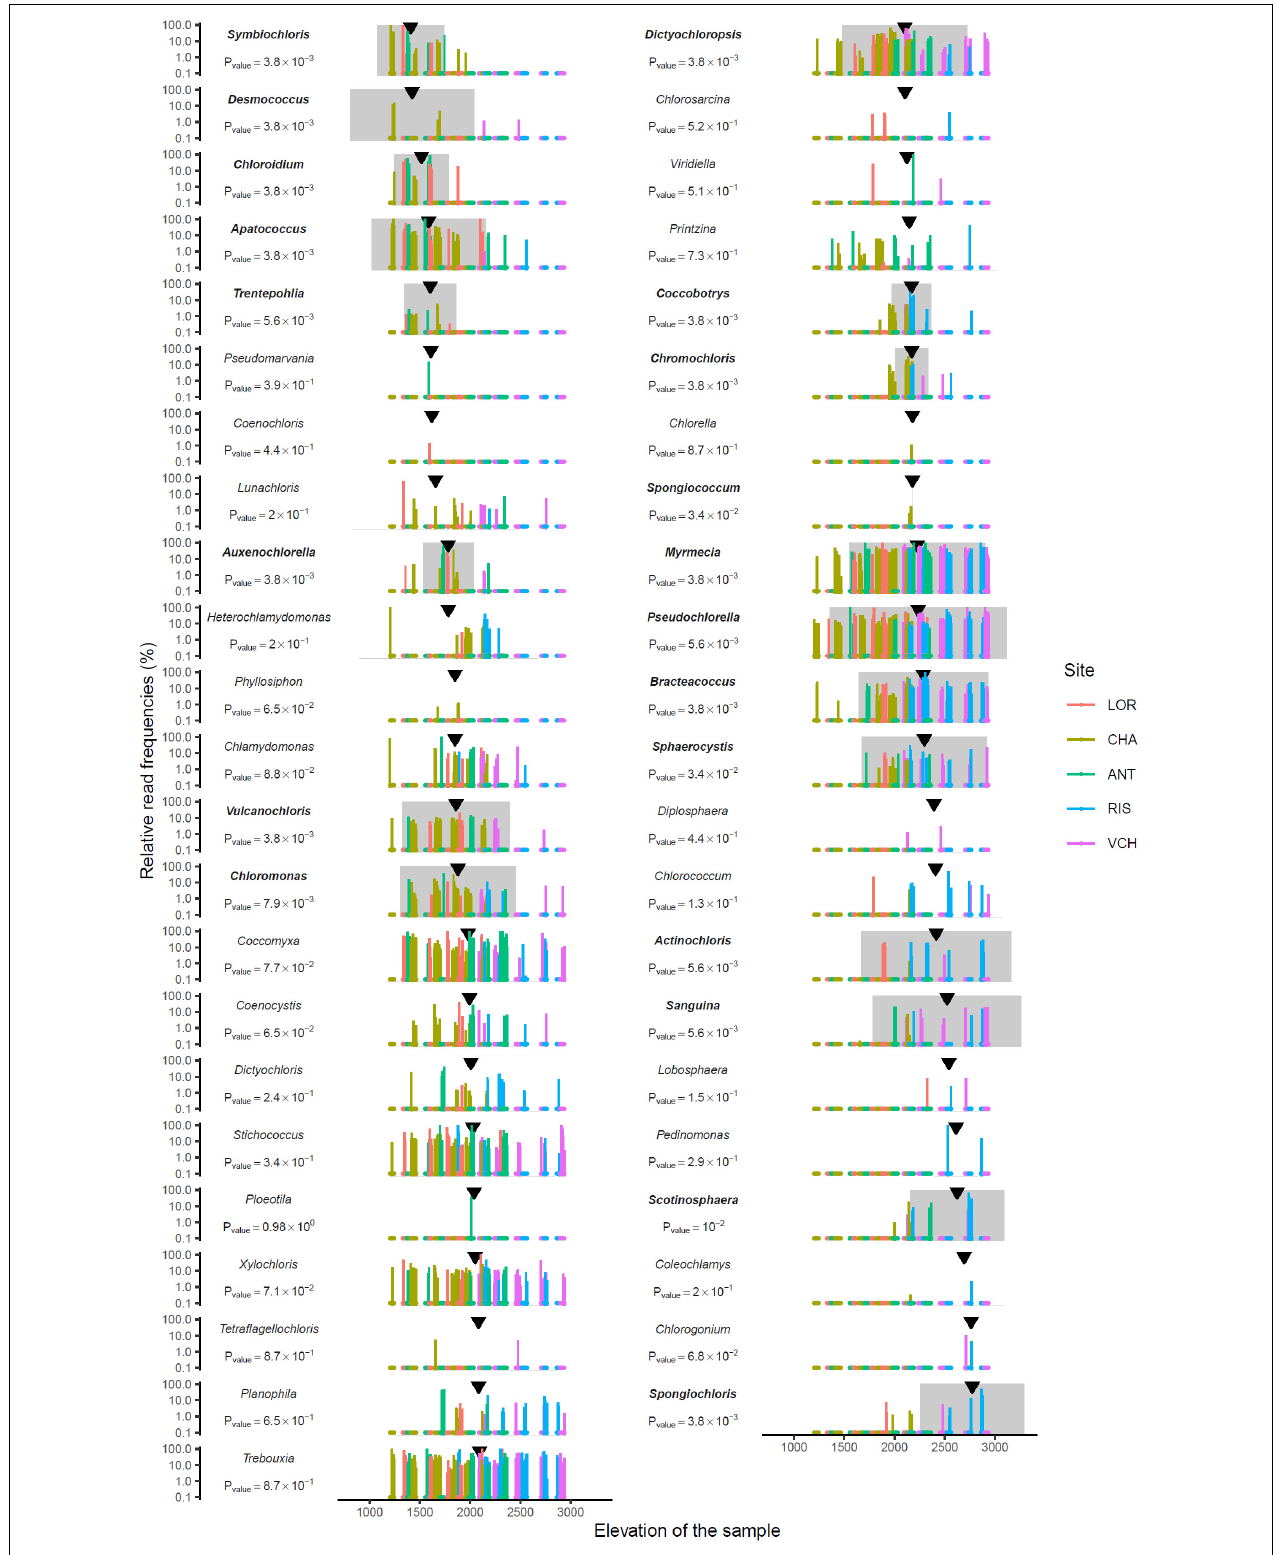
FIGURE 9 | Read relative frequency along elevation for each genus identified. Arrows indicate the median. The range in grey centered on the pic of density is where the MOTU is the most abundant. P -values were evaluated using the Mann–Whitney test. Bold taxon names indicate a significant p -value at 0.05.